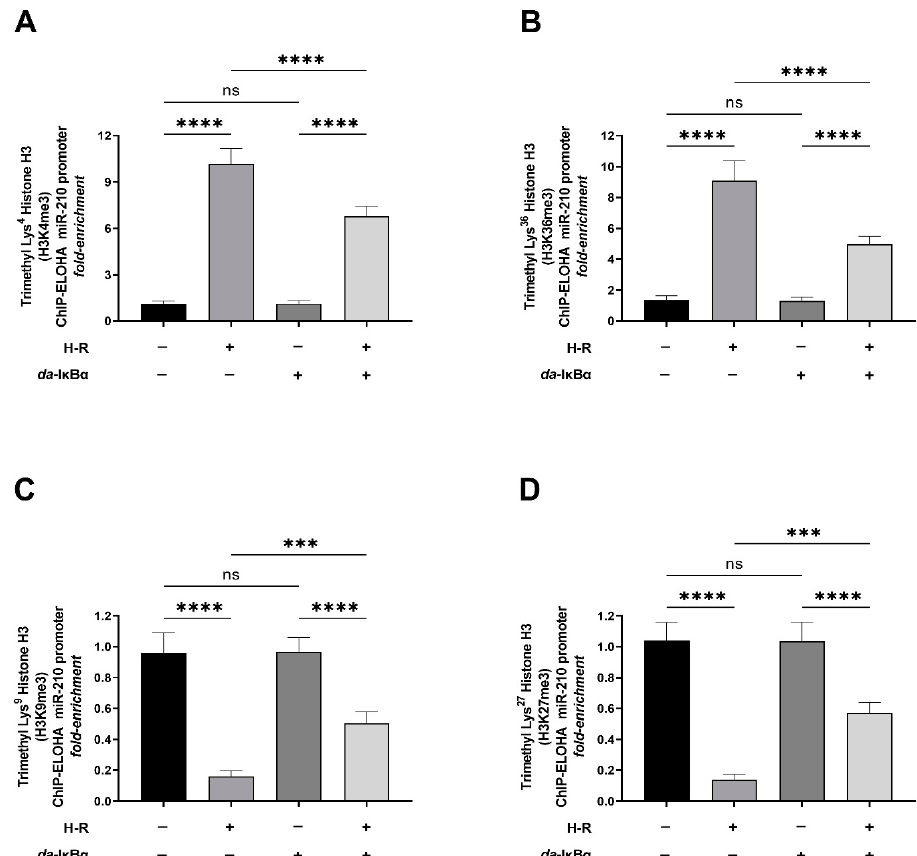
Figure 7. NF- κ B activation significantly mediates the hypoxia–reoxygenation (H-R) challenge-induced changes in methylation of characteristic lysine residues in histone H3 that are signatory of an open permissive and transcriptionally active miR-210 promoter. ( A , B ) Tandem ChIP-ELOHA analysis of the miR-210 proximal promoter showing the relative abundance of histone H3 trimethylated at ( A ) Lys 4 —H3K4me3 and ( B ) Lys 36 —H3K36me3, a molecular hallmark of a permissive active promoter that is associated with transcriptional activation. ( C , D ) Tandem ChIP-ELOHA analysis of the miR-210 proximal promoter showing the relative abundance of histone H3 trimethylated at ( A ) Lys 9 —H3K9me3 and ( B ) Lys 27 —H3K27me3, a molecular hallmark of a refractory promoter that is associated with transcriptional repression. Data from the ChIP-ELOHA analysis are expressed as fold enrichment by first correcting the respective acetylated histone H4-associated miR-210 promoter fragment ELOHA absorbance values to the respective inputs , followed by normalization to fold change values. Data from the ChIP-ELOHA analysis are depicted as mean fold enrichment ± S.D. from three technical replicates for each of the four biological replicates belonging to each experimental group ( n = 4). *** p ≤ 0.001; **** p ≤ 0.0001; ns: not significant ( p > 0.05). S.D.: standard deviation.